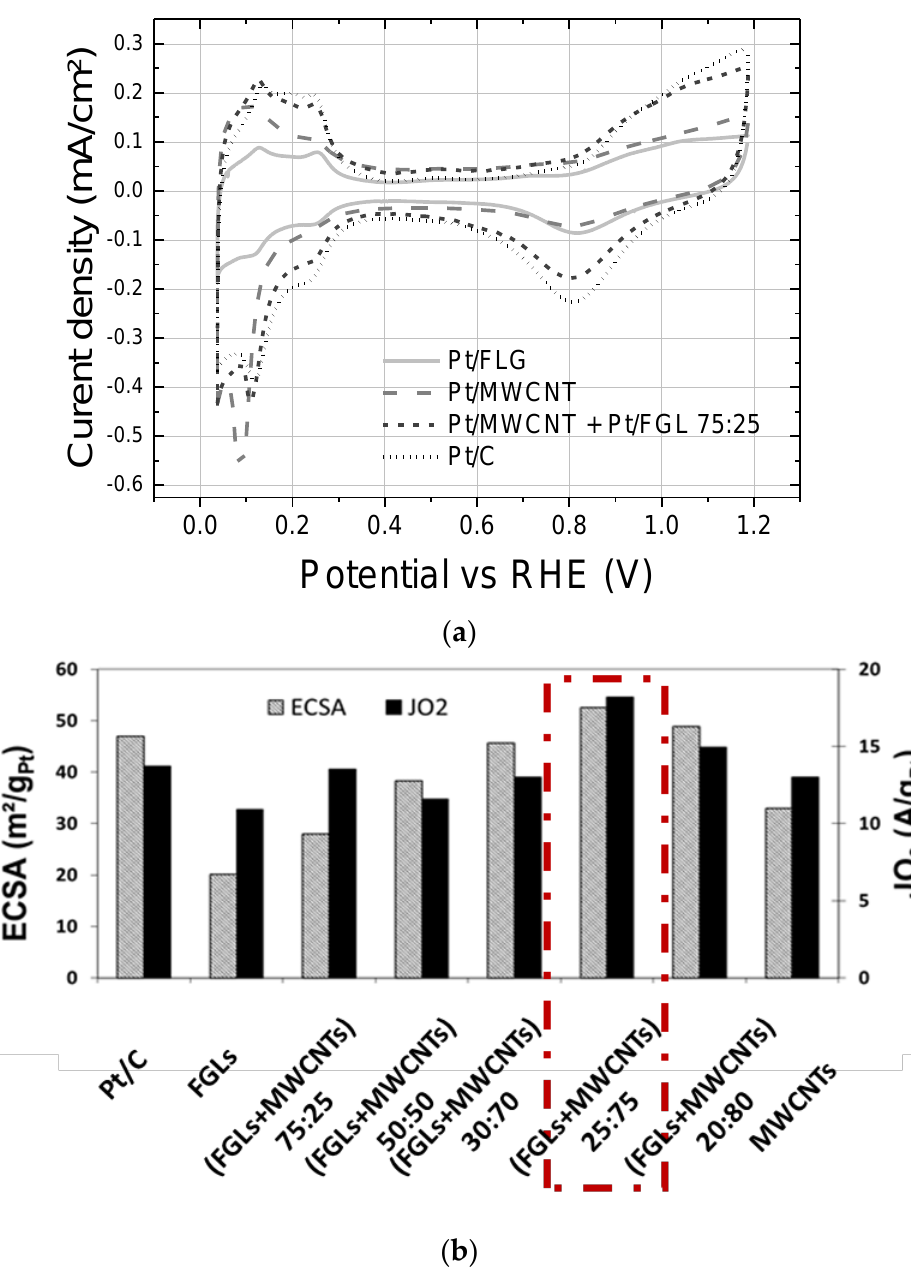
Figure 3. ( a ) Comparison of the cyclic voltammograms of the catalysts in 0.5 M H2SO4, 5 mV·s −1 and ( b ) the calculated ECSA and current density for the as-prepared catalysts compared with commercial